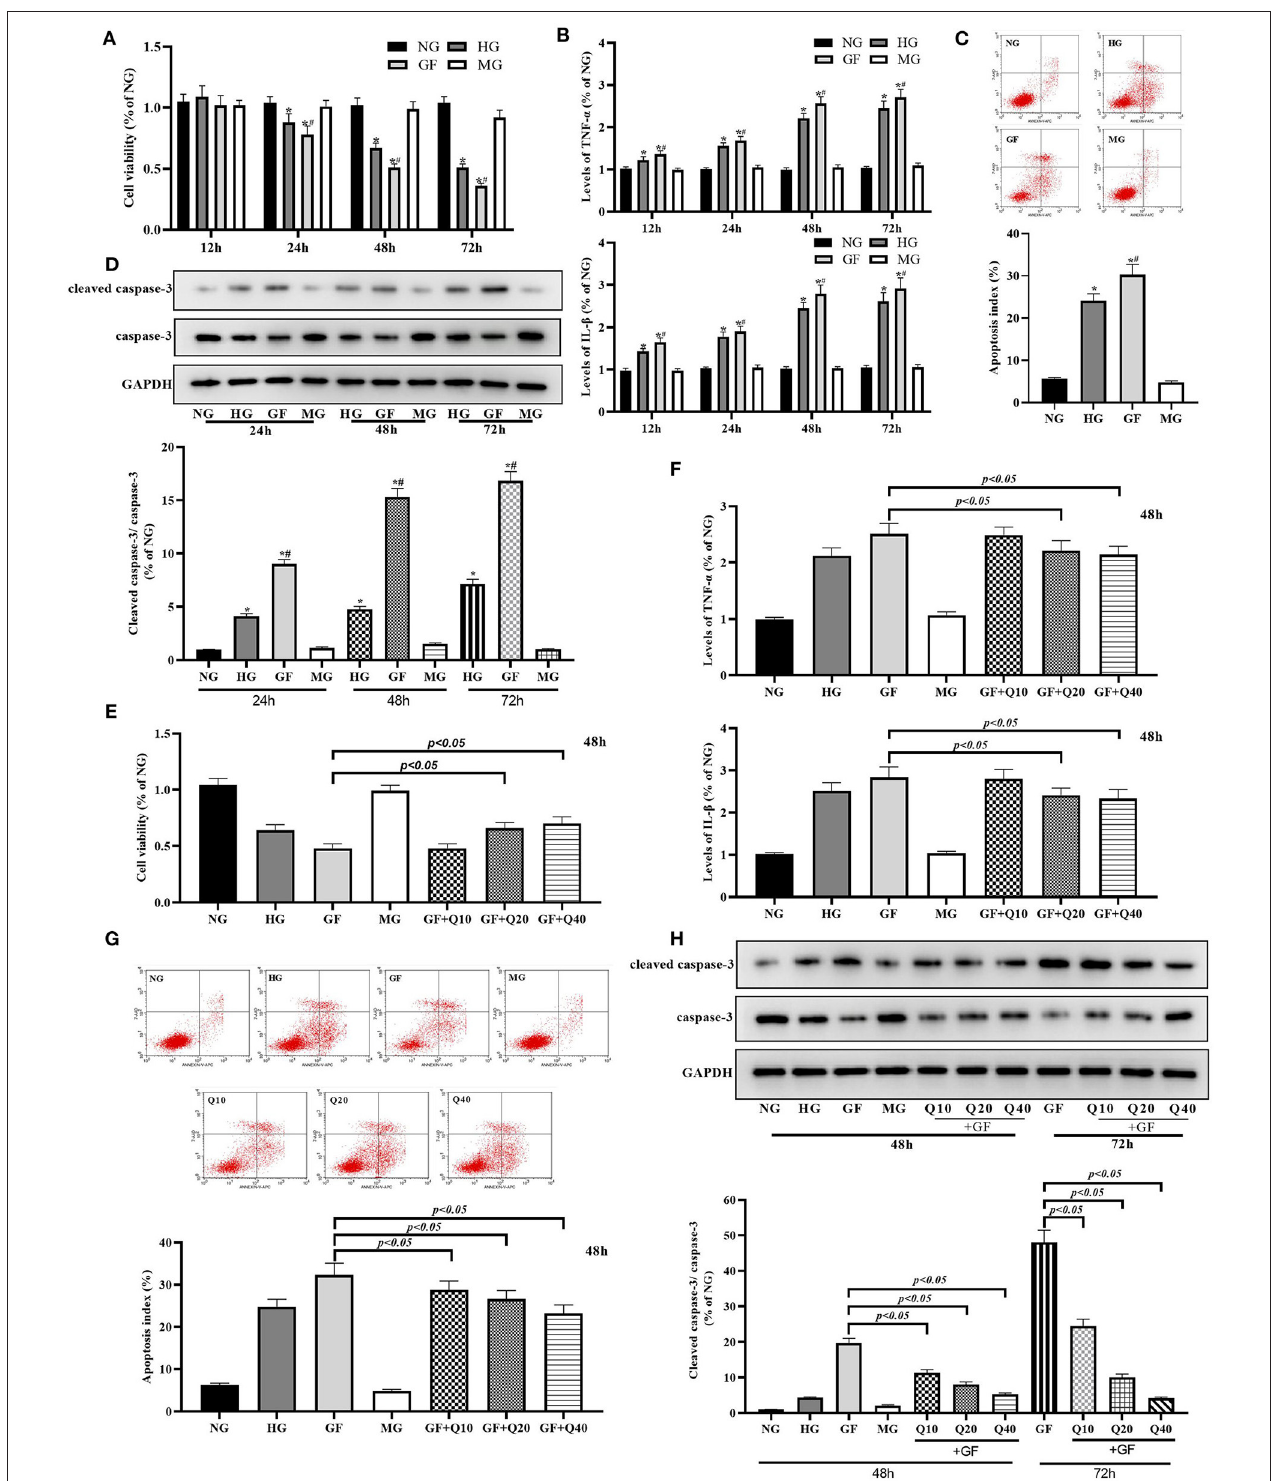
FIGURE 1 | Quercetin protected glomerular MCs from GF-induced inflammation and apoptosis injuries. (A) Viability of MCs was tested by CCK8 at 24, 48, and 72h. (B) Inflammation levels of TNF α and IL-1 β at 24, 48, and 72h. (C) Apoptosis index was detected by flow cytometry under different glucose at 48h. (D) Rates of cleaved caspase-3/caspase-3 measured by WB analysis at 48h. (E,F) Moderate (20 µ mol/L) and high dose (40 µ mol/L) of quercetin treatment presented protection effects on viability of MCs and levels of inflammation damage. (G,H) Effects of quercetin on apoptosis index and caspase-3 activity. The error bar reflects the S.E.M. of at least three independent experiments. * P < 0.05 vs. NG. # P < 0.05 vs. HG.